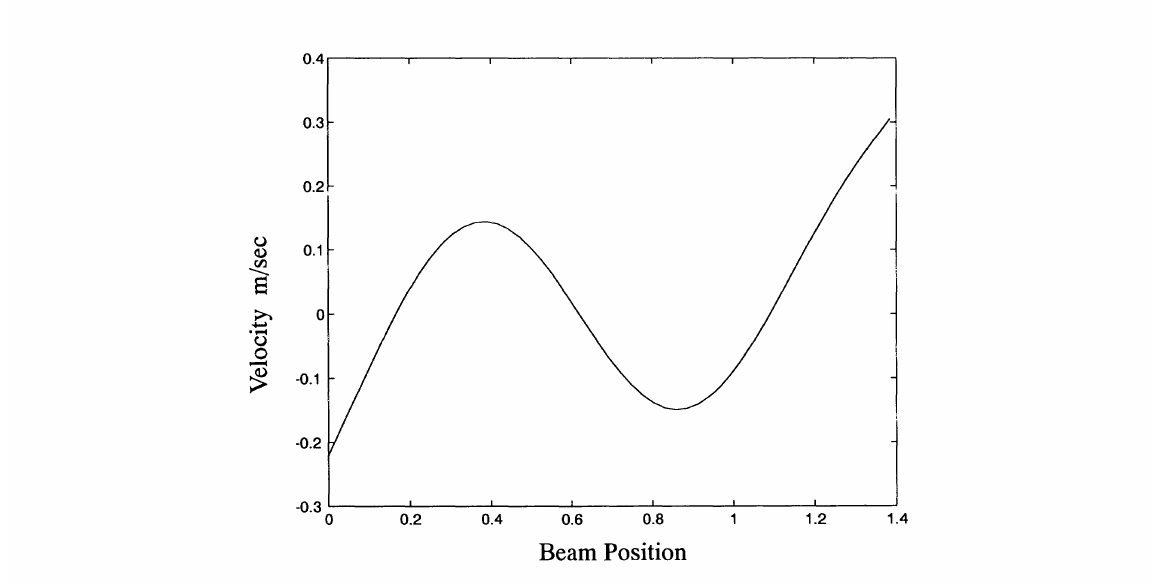
FIGURE 7 Imaginary component of the velocity field over the